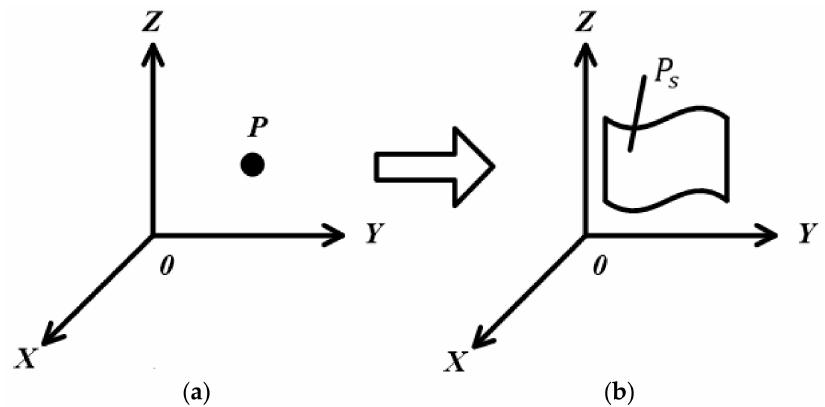
Figure 10. The 3D Hough transform: ( a ) The parameter space; ( b ) The image space. Di ff erent representations of coordinate space correspond to di ff erent 3D Hough transforms.